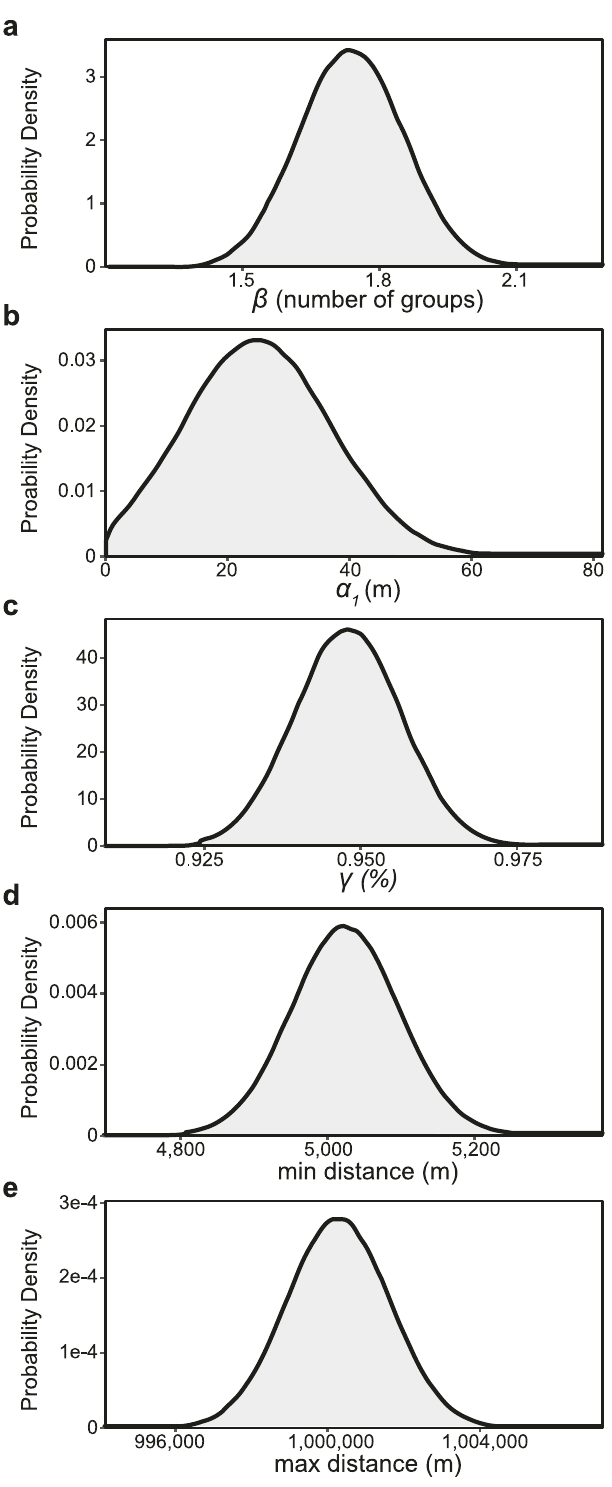
Fig. 7 Parameter distributions. a Reproductive rate ( β ), b natural dispersal distance ( α 1), c percent natural dispersal ( γ ), d minimum distance ( d min) , e maximum distance ( d max